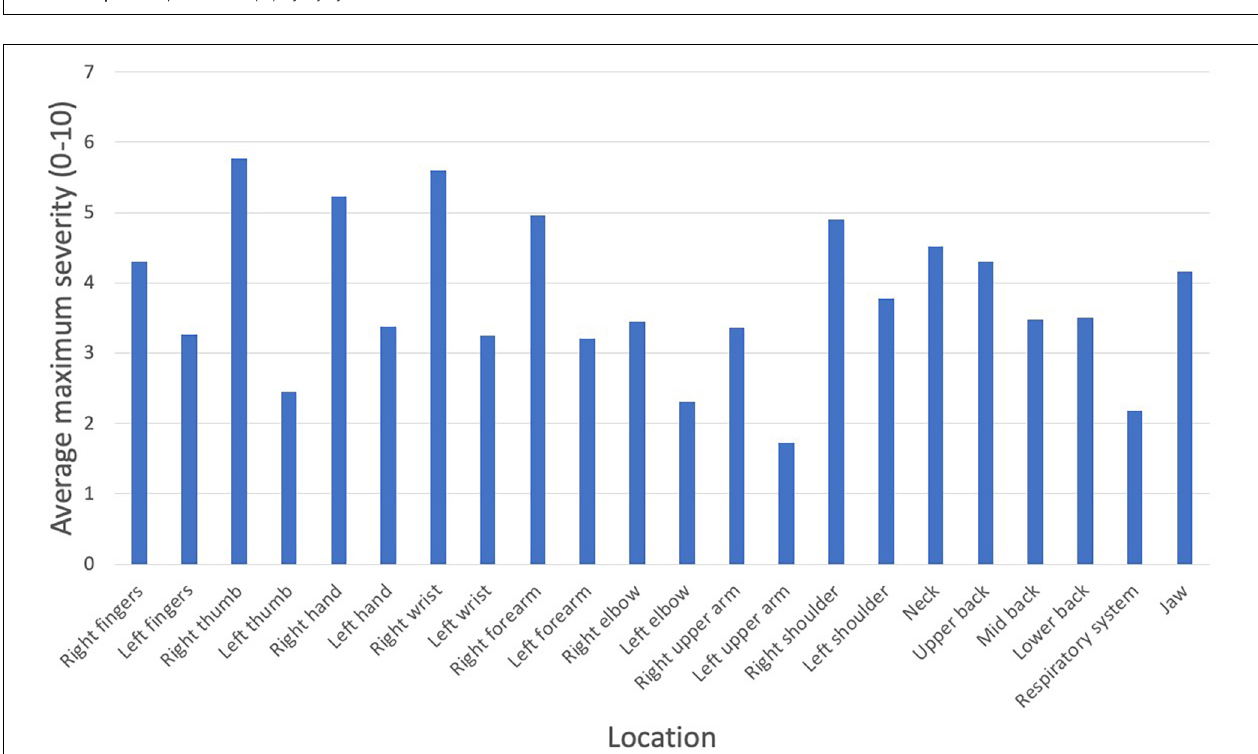
FIGURE 5 | PRMD average maximum severity (scale of 1 to 10) by injury location.